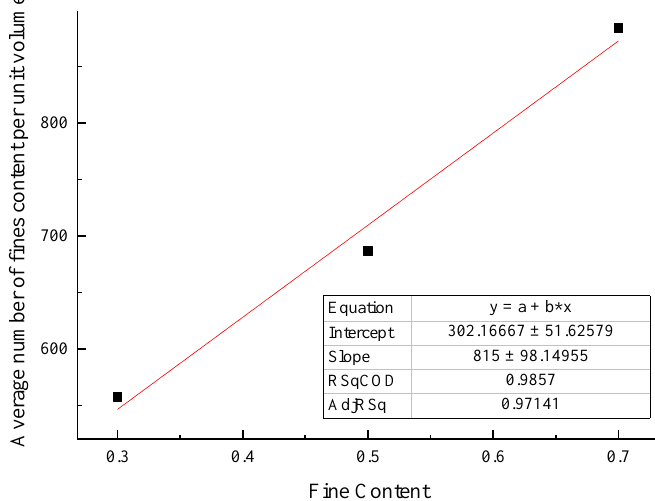
Figure 20. Relationship between the proportion of the fine content and the initial content of fine particles.